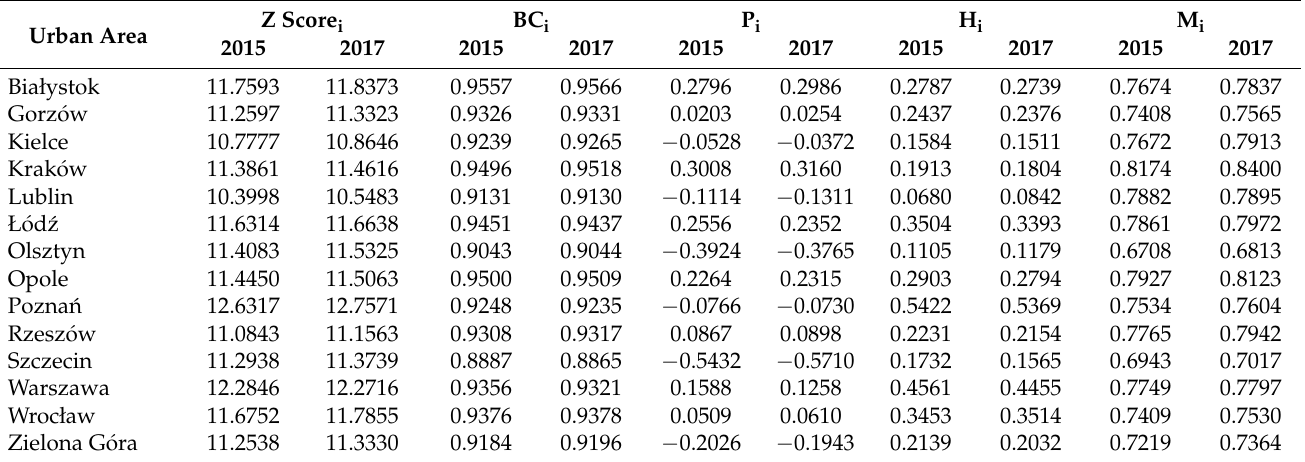
Table 5. Urban sprawl indexes according to selected methods for 2015 and